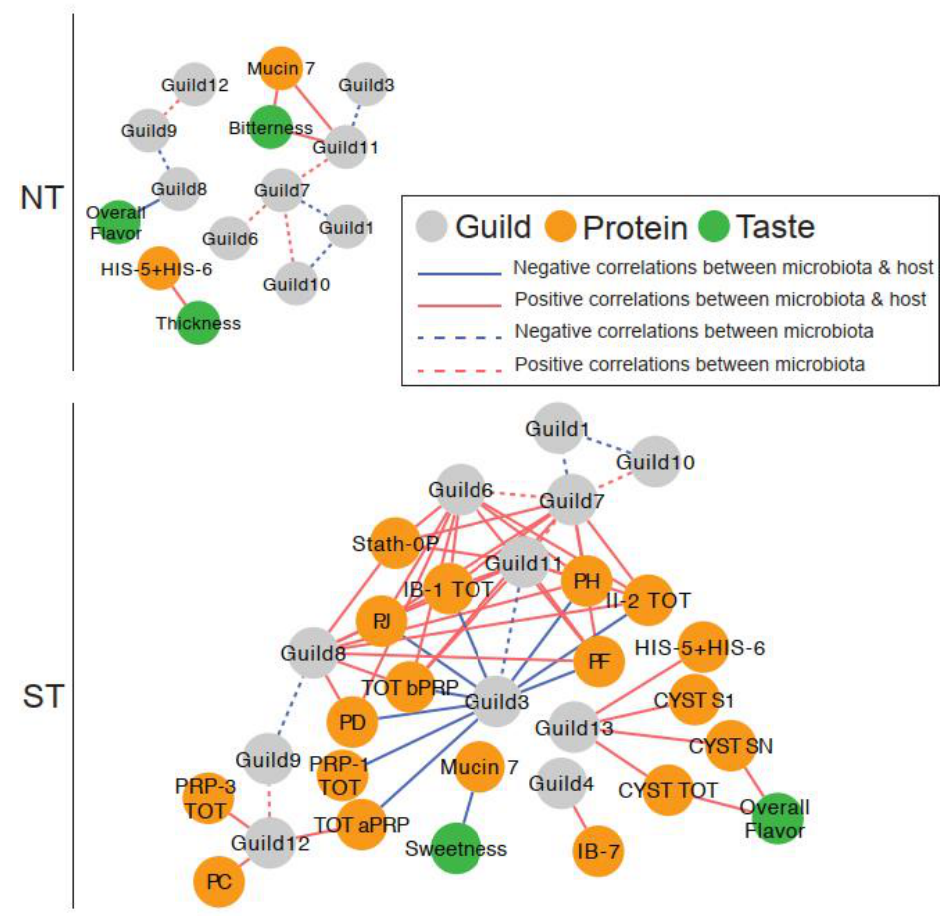
Figure 8. The associations between taste, salivary proteins, and oral microbiota were more complex in PROP STs than in NTs. In the correlation networks, solid edges represent the correlations between taste and guilds, between salivary proteins and guilds, and between taste and salivary proteins. Dashed edges represent the correlations between guilds. The color of the edges represents the pos- itive (red) and negative (blue) correlations. All correlations with adjusted p < 0.25 were shown in the networks. Salivary protein abbreviations are explained in Supplementary Table S1.